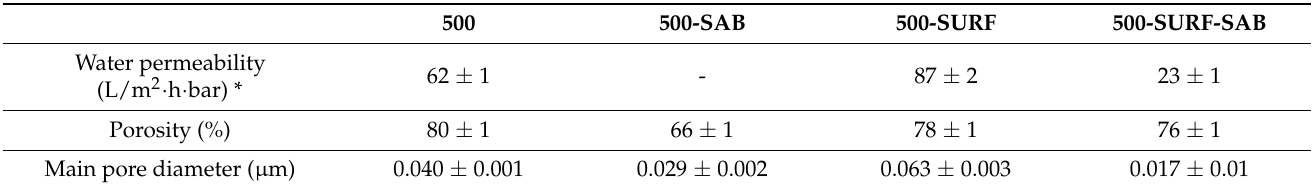
Table 3. Performance in terms of water permeability, porosity, and pore size of the membranes pre- pared with 5 wt% of Pluronic F-127 in water (500-SURF) and in a saturated salt bath as a coagulation bath